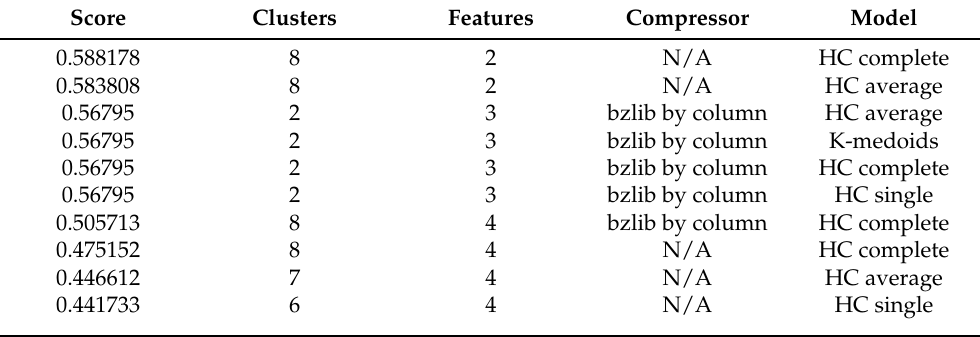
Table 7. Silhouette scores of the best five clustering by compression and the best five standard compression models for the Golimumab dataset. N/A means that no compressor was